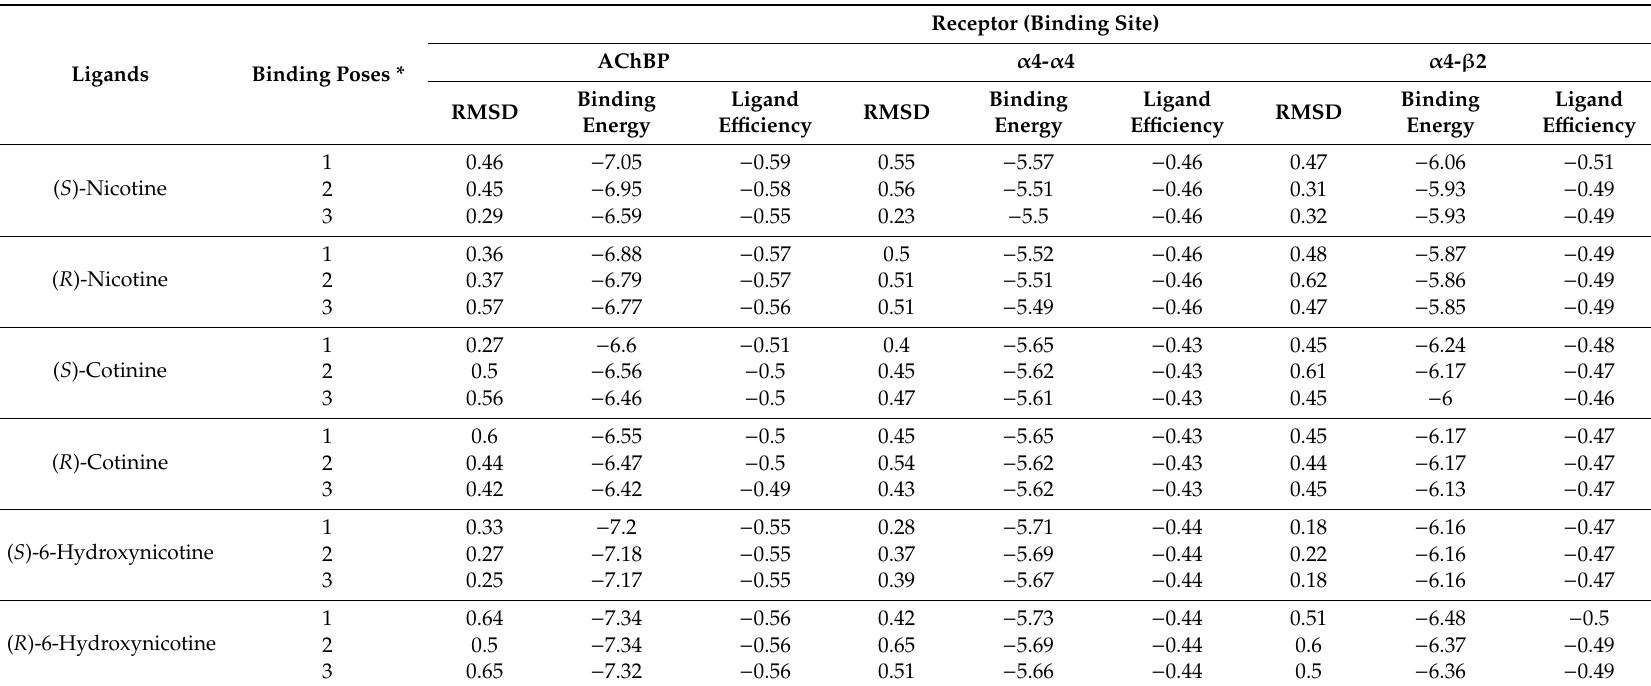
Table 3. The root mean square deviation (RMSD), binding energies and ligand e ffi ciencies for the best three binding poses of the ligands in the corresponding